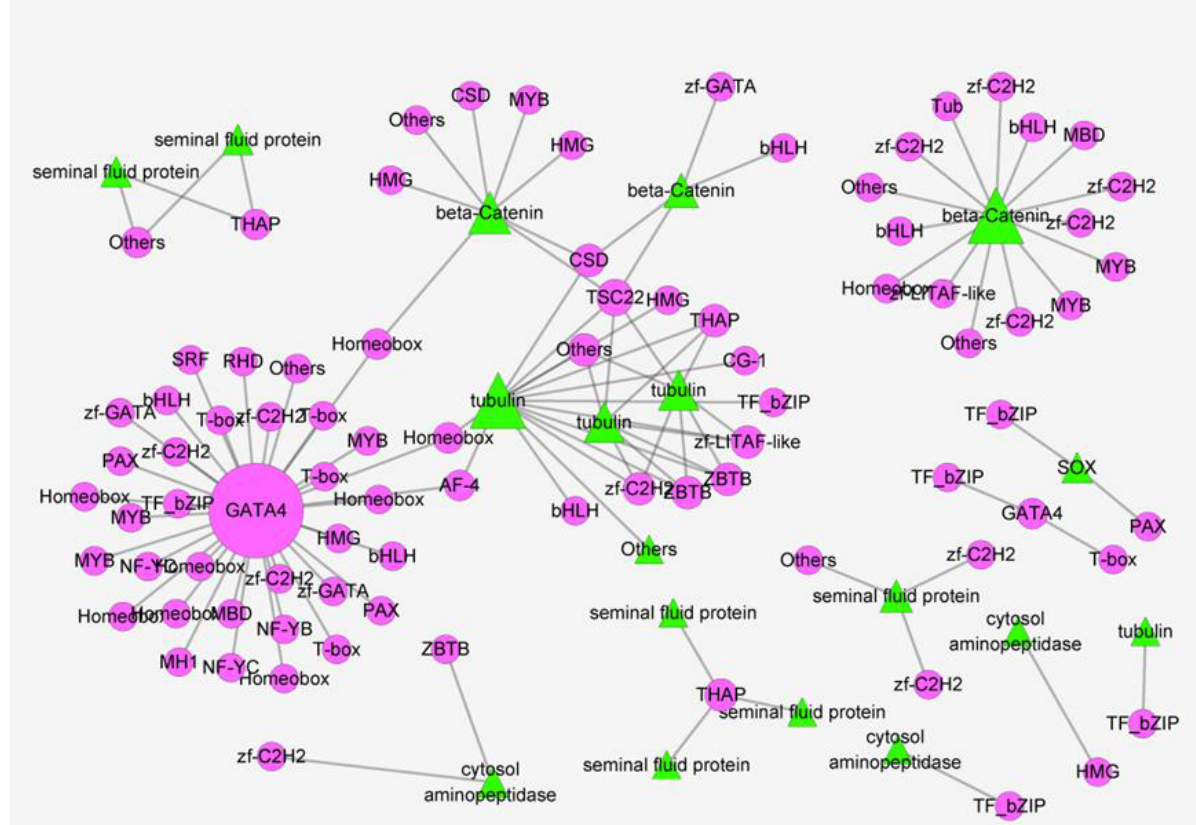
Figure 9. PPI network of sex determination and differentiation-related genes in Chilo sacchariphagus.